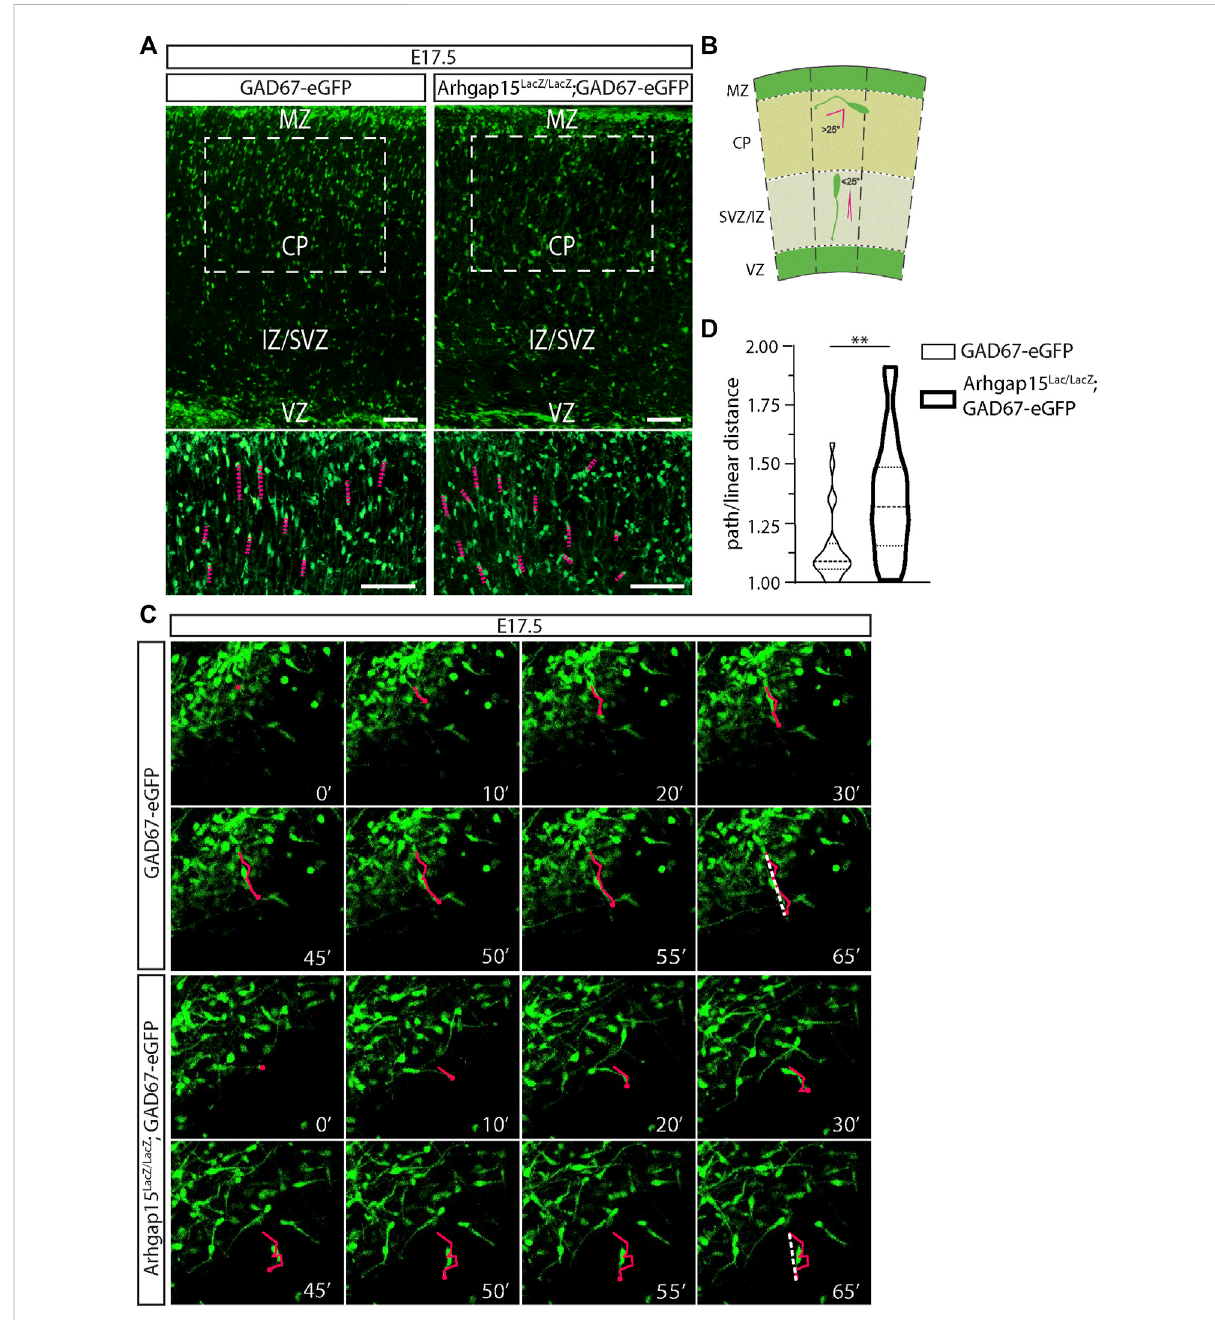
FIGURE 5 CIN radial migration in the embryonic cortex. (A) Maximum intensity projections of z-stack images (5 serial image planes; z step size = 1 μ m) of E17.5 GAD67-eGFP and Arhgap15 LacZ/LacZ ; GAD67-eGFP mouse cortices. Scale bars: 100 µm. The bottom panels show a higher magni fi cation of the region in the dashed box. Scale bars: 100 µm. (B) Schematic representation of the criteria used to discriminate between tangential and radial migrating CINs. The dashed lines indicate perpendicular lines to both the pia and ventricle. Leading processes forming an angle higher than 25 ° with thedashed lineare classi fi edas tangentiallymigratingCINs, while theonesforming an angle lowerthan (or equal to) 25 ° areclassi fi edas radially migrating CINs. (C) Frames of representative time-lapse videos (Suppl. Videos 1 and 2) of E17.5 GAD67-eGFP and Arhgap15 LacZ/LacZ ; GAD67-eGFP mouse cortices at different time points (from 0 to 65 min). In each frame, the tip of the leading edge of representative neurons was marked to reconstruct the migratory path. In the last frame (65 ′ ), the dashed line shows the linear distance covered by the leading edge. (D) Average ratio betweenthepathandthelineardistancecoveredby GAD67-eGFPandArhgap15 LacZ/LacZ ; GAD67-eGFP radiallymigratingneuronsinthetimewindow of the time-lapse video. At least 50 neurons from 3 different mice were analyzed for each genotype. p = 0.007. Data are presented as mean ± SEM. p -value was calculated using unpaired Mann – Whitney test. ** = p < 0.01. MZ, marginal zone; CP, cortical plate; IZ, intermediate zone; SVZ, subventricular zone, VZ, ventricular